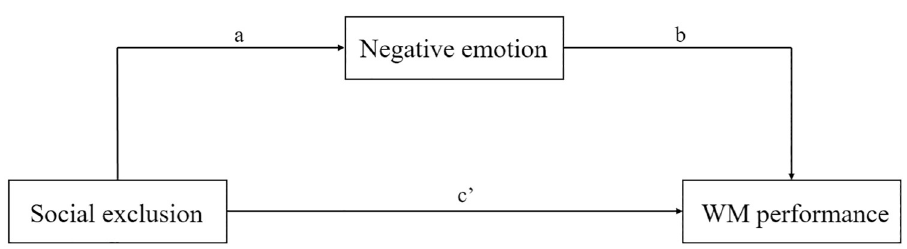
Fig 4. Mediation model of negative emotion between social exclusion and WM performance.